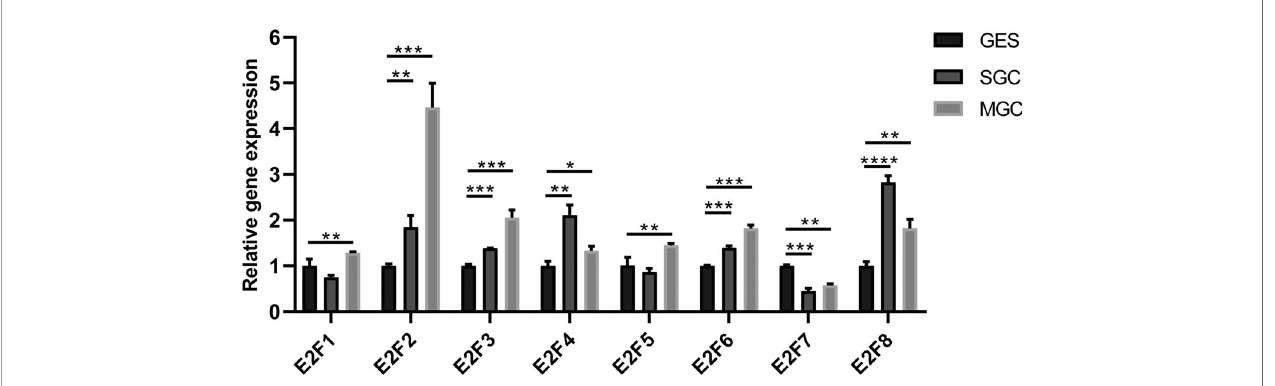
FIGURE 3 | Differential expressions of E2Fs in GC cell lines and normal gastric epithelial cell line. MGC, gastric cancer cell line MGC-803; SGC, gastric cancer cell line SGC-7901; GES, normal gastric epithelial cell line GES-1. * p < 0.05, ** p < 0.01, *** p < 0.001, and **** p < 0.0001.